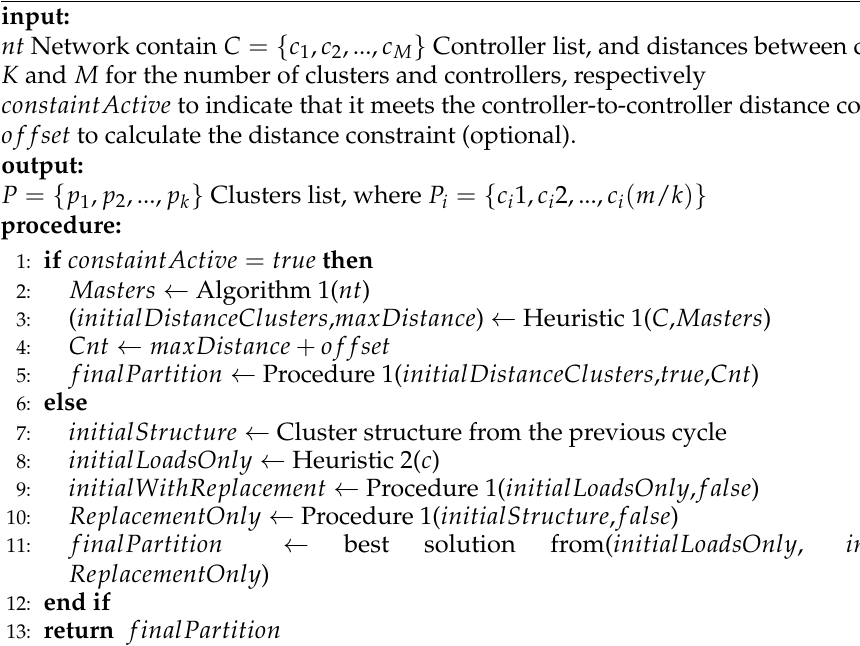
Algorithm 2 DCC